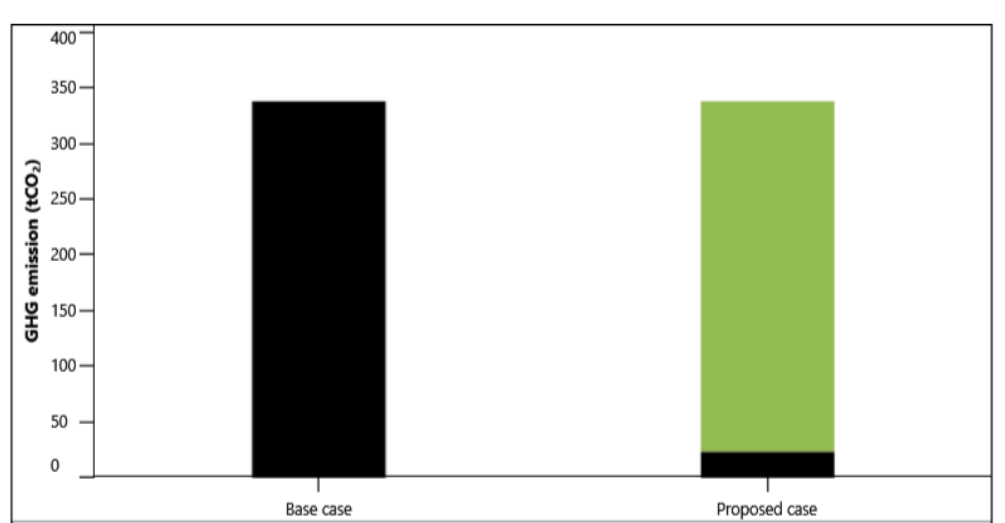
Figure 10. GHG emission reduction. Table 7. Gross annual reduction in GHG emissions of di ff erent 600 kW PV technologies in RET- Screen.